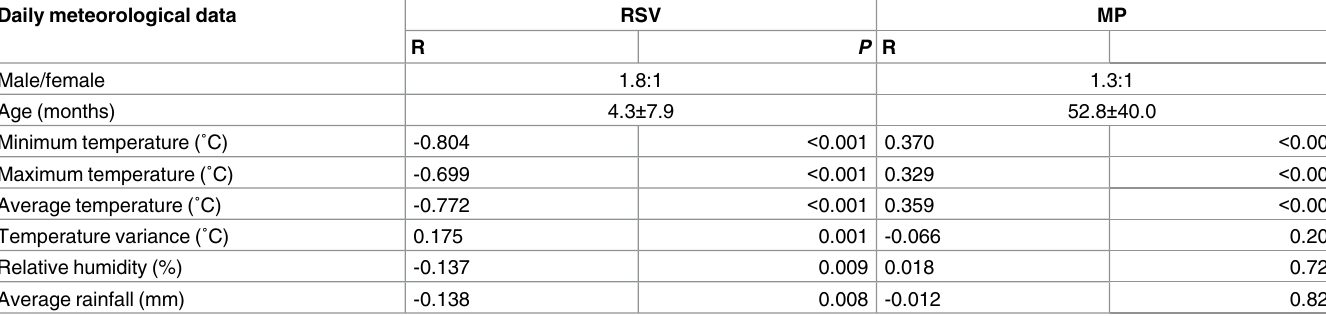
Table 1. Correlation analysis between meteorological factors and MP/RSV infection in Hangzhou.